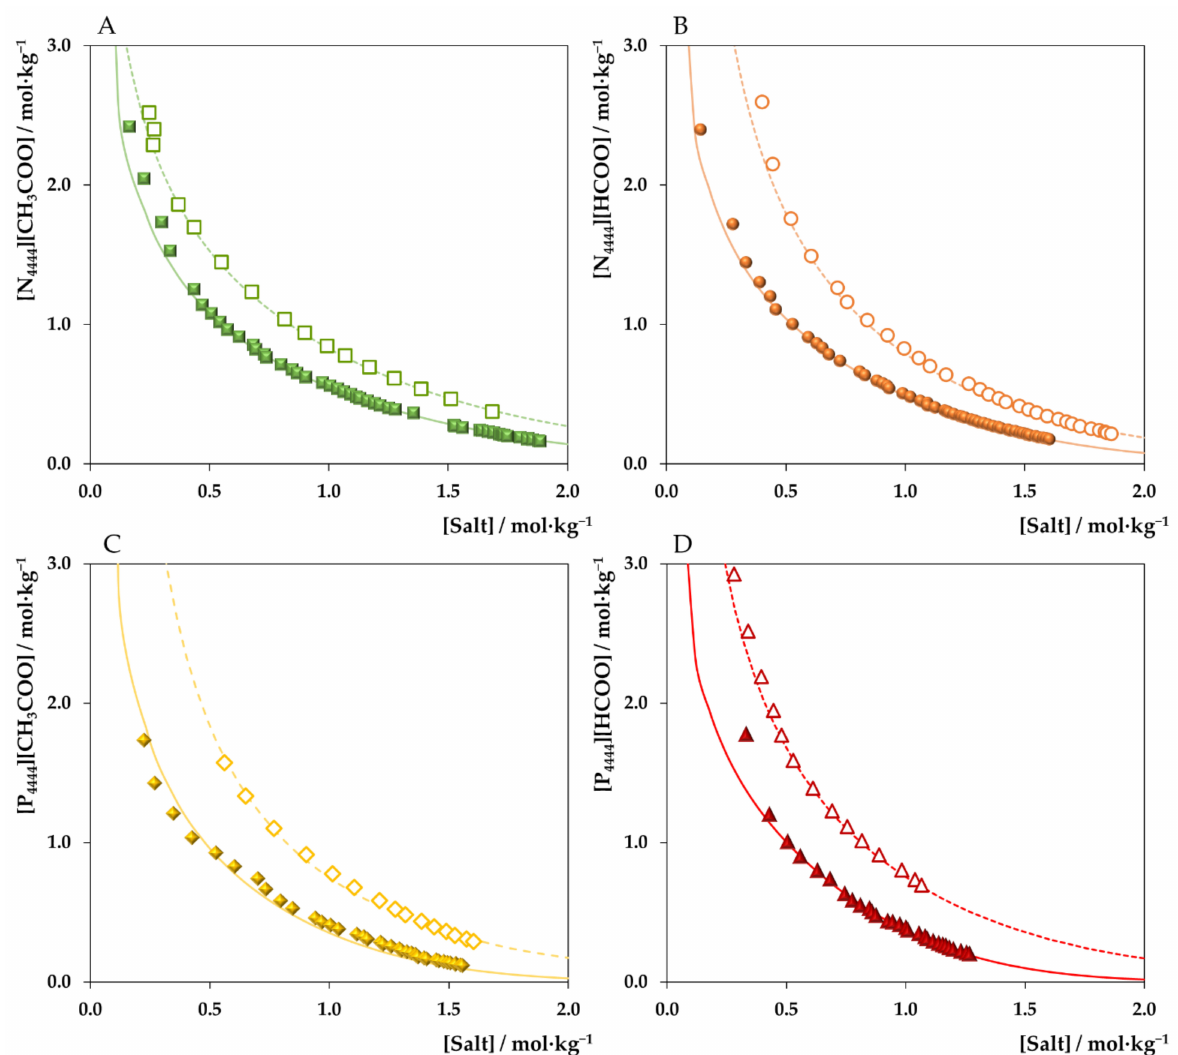
Figure 3. Binodal curves of ABSs comprising [N 4444 ][CH 3 COO] ( A ), [N 4444 ][HCOO] ( B ), [P 4444 ][CH 3 COO] ( C ) and [P 4444 ][HCOO] ( D ) and salts at 25 ◦ C and atmospheric pressure: K 2 HPO 4 (closed symbols) or C 6 H 5 K 3 O 7 (open